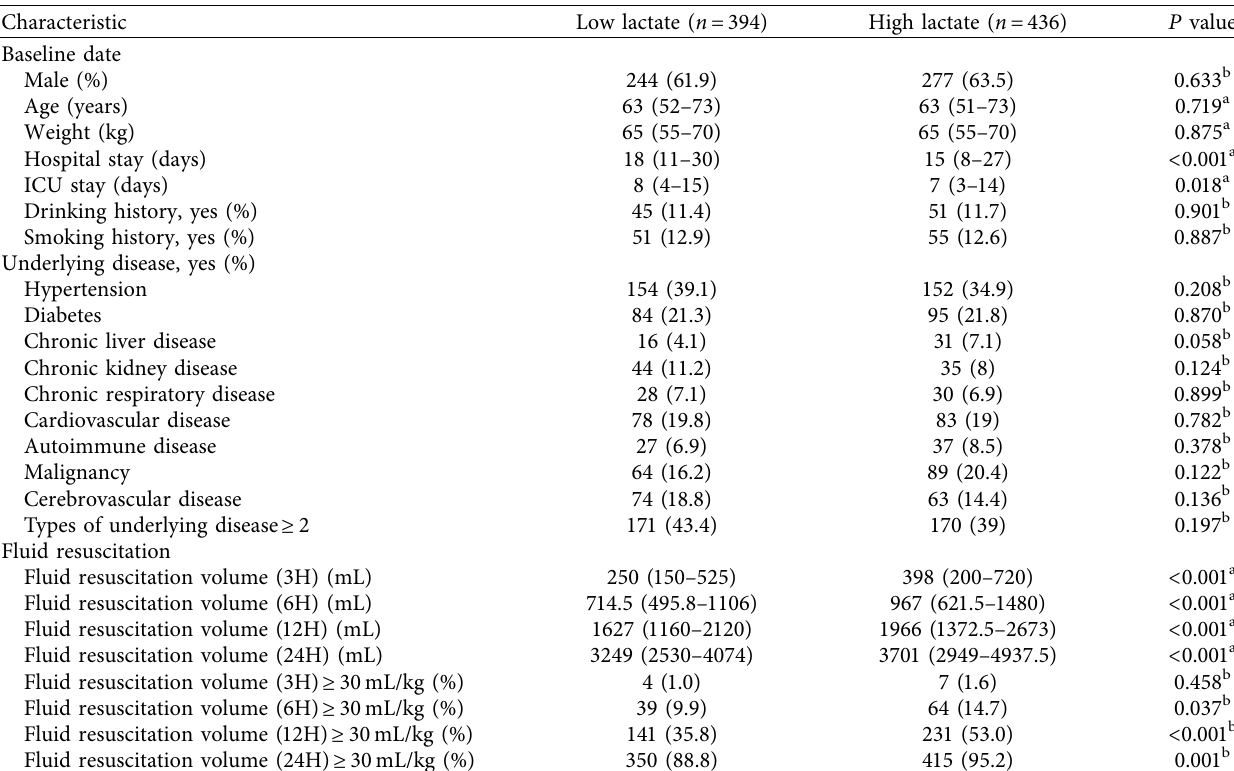
Table 4: Baseline data and fuid resuscitation comparison of patients in the high lactate group and the low lactate